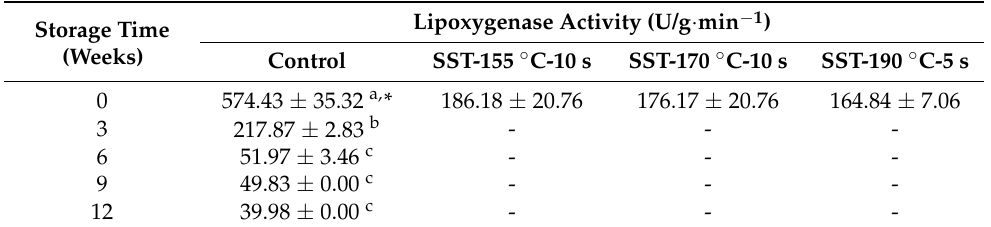
Table 2. Effect of superheated steam treatment on lipoxygenase activity of dried whole wheat noodles during storage.